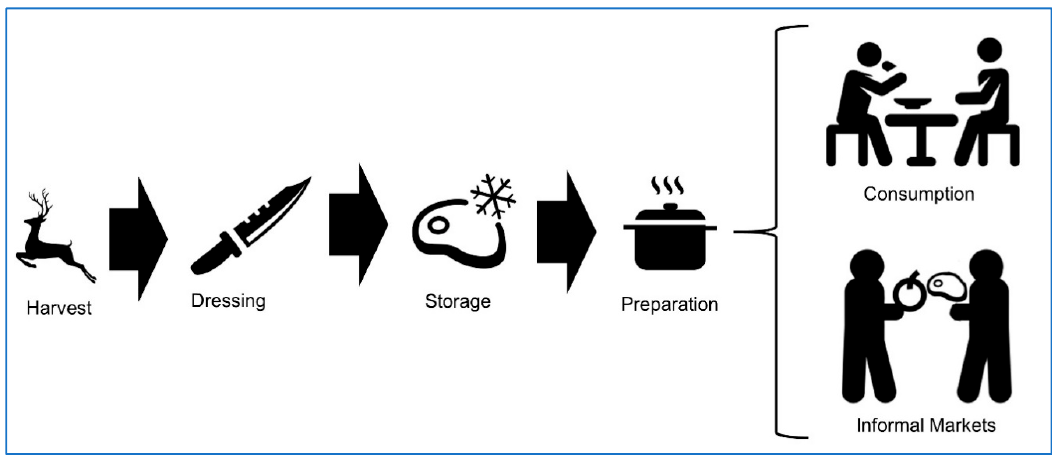
Figure 1. Conceptual diagram of the food chain process of terrestrial mammalian game meat in North America. North